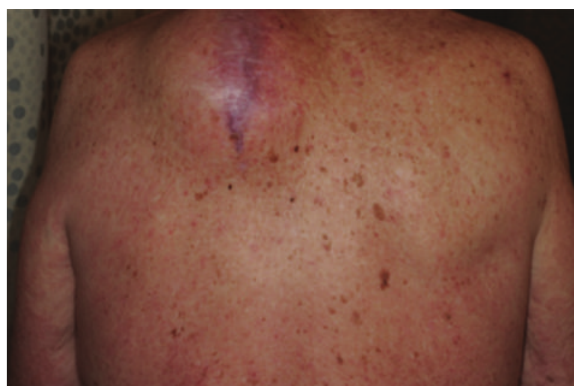
Figure 4: Immune-related maculopapular rash in a patient receiv- ing ipilimumab.